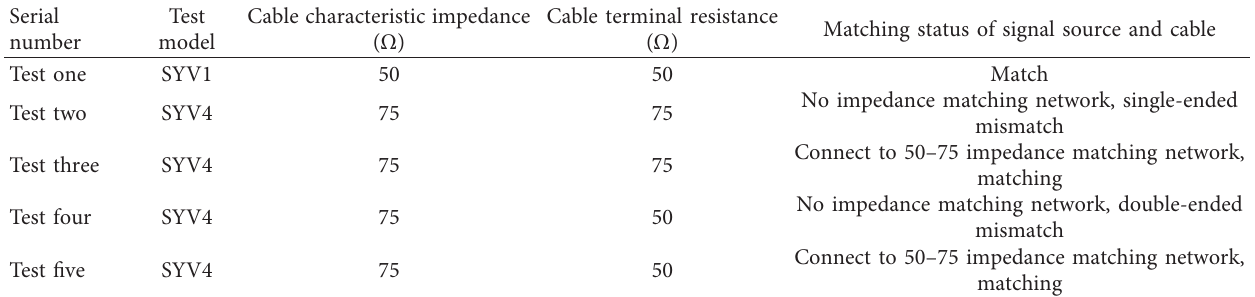
Table 2: Grouping of tested cables.